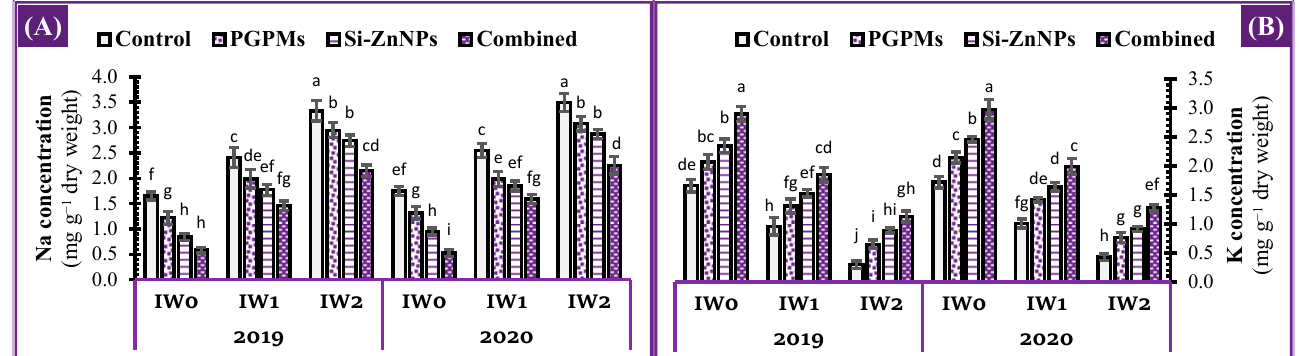
Figure 2. Influence of application of PGPMs, Si-ZnNPs and their combination on the concentration of ( A ) sodium (Na + ), and ( B ) potassium (K + ) in the leaves of soybean plant grown in salt-affected soil with different levels of watering intervals ( IW 0 ; 11 days, IW 1 ; 15 days, and IW 2 ; 19 days) during the successive 2019 and 2020 growing seasons. The data presented as means ± SD. Means labeled with the same lower-case letter are not significantly different according to Duncan’s Multiple Range Test.